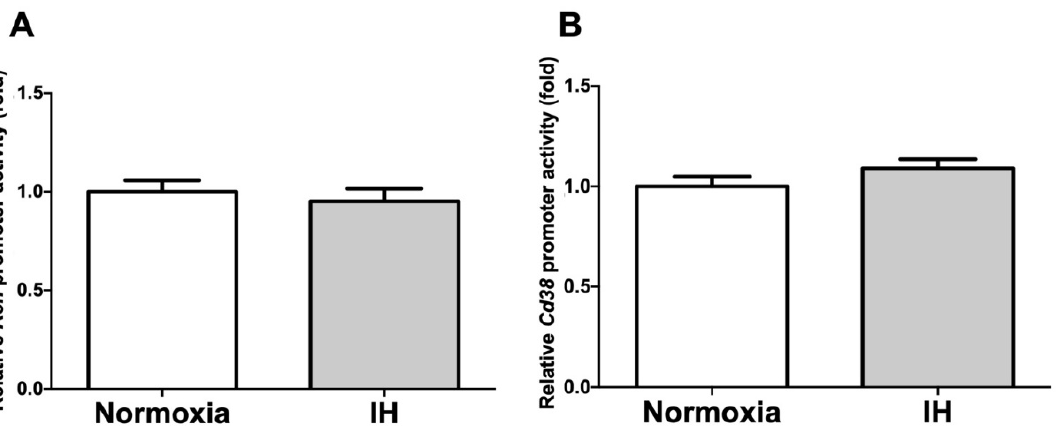
Figure 8. Promoter activities of Ren ( A ) and Cd38 ( B ) in the As4.1 JG cells. Reporter plasmids prepared by inserting the promoter fragments of Ren ( − 4094 ~ +33) and Cd38 ( − 4888 ~ +92) upstream of a firefly luciferase reporter gene in a pGL4.17 vector were transfected into the As4.1 cells. After the cells were exposed to either IH or normoxia for 24 h, they were lysed, and the promoter activities of Ren and Cd38 were measured. All the data are represented as the mean ± SE of the samples of six independent experiments (n = 6). The statistical analyses were performed using a Student’s t -test.